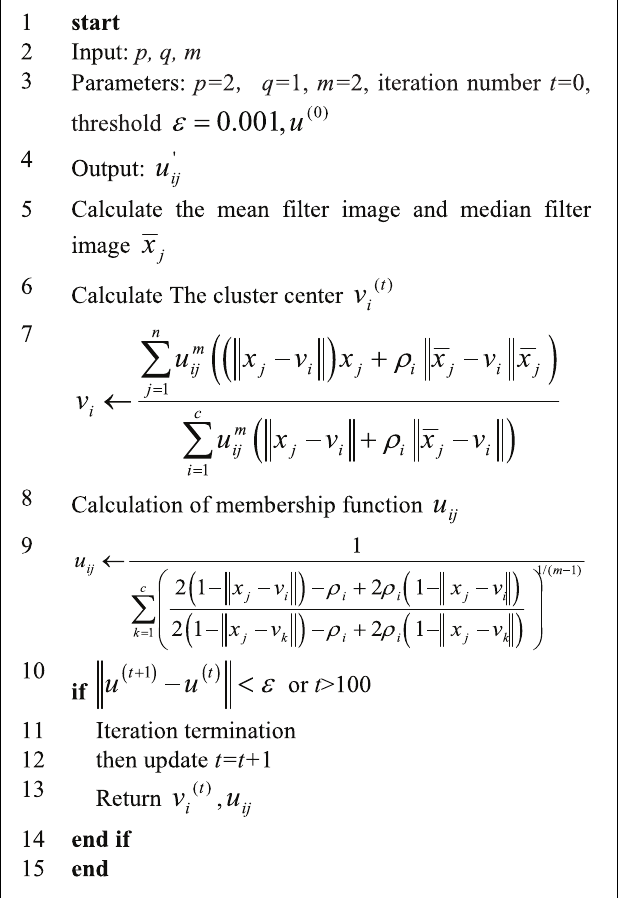
FIGURE 5 | Flowchart of the improved fuzzy clustering algorithm